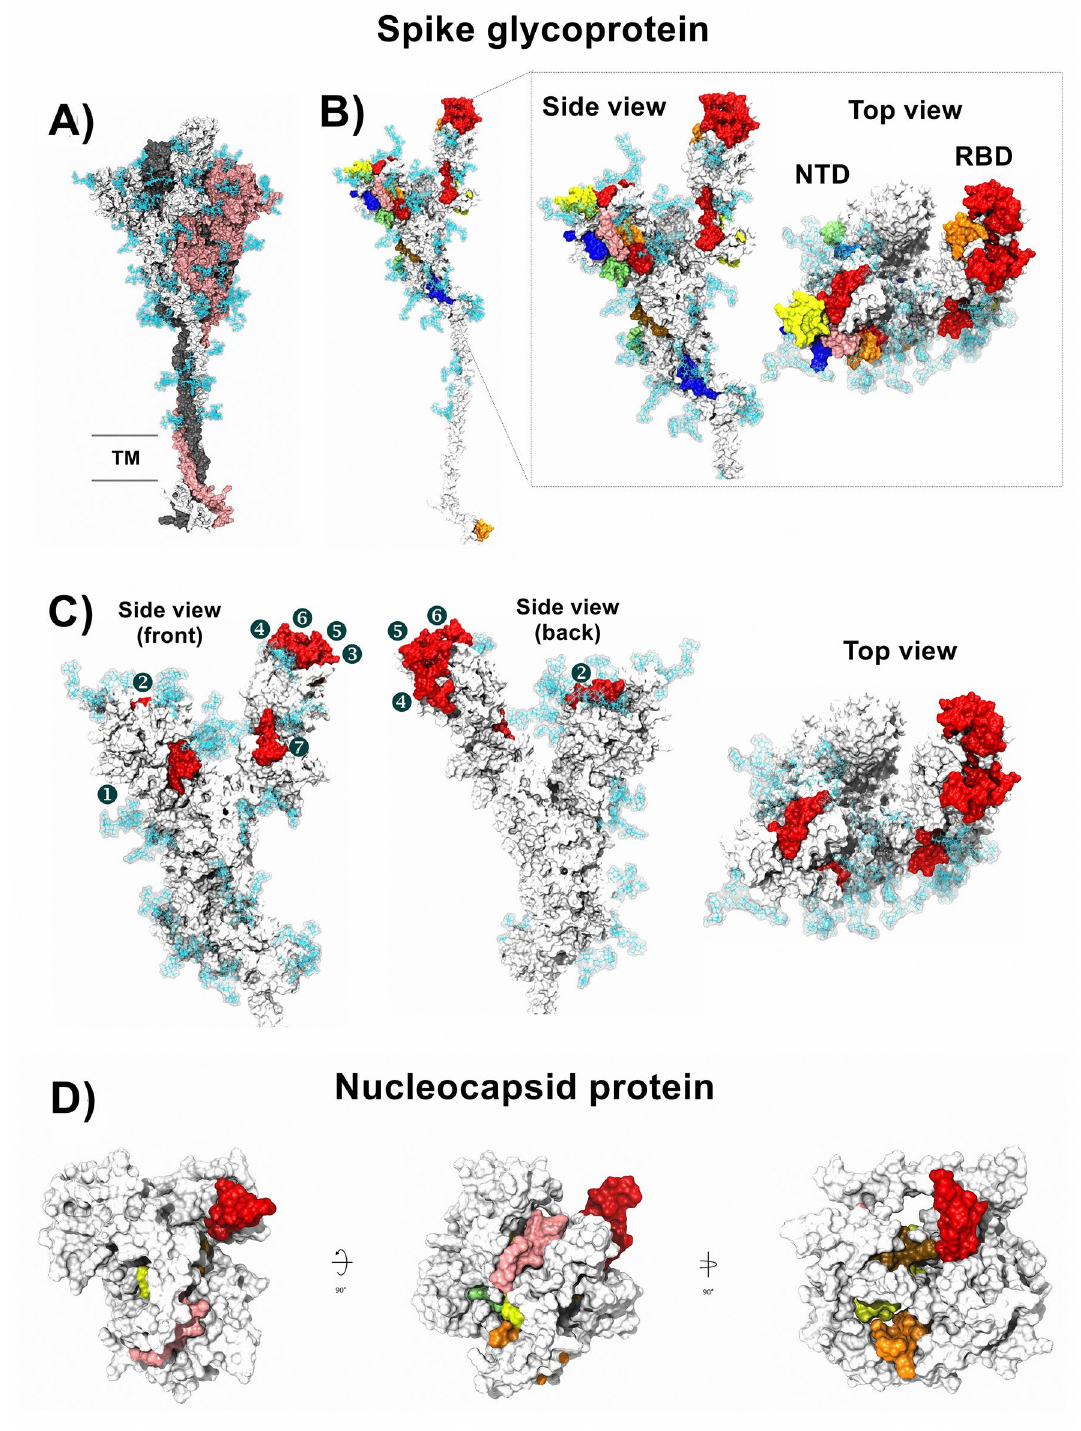
Figure 1. Localization of immunogenic and antigenic peptides in the 3D structures of SARS-CoV-2 S and N proteins. ( A ) The structure of the glycosylated trimeric S protein is shown in a side view. ( B ) Localization of all selected peptides in the monomeric glycosylated form of S protein. In the frame, the zoom of the side and top views of the S1 domain in the monomeric form of S protein shows the localization of each selected peptide in color patterns (see Supplementary Material S2). ( C ) Localization of the seven selected peptides (red) for the synthesis of MAP8 format is shown with numbers in side view (front and back) and top view. Glycans are represented as cyan lines of surf structures, and the transmembrane viral region is represented with two lines in gray (TM). ( D ) General view of a model structure of nucleocapsid protein. The color pattern used for each immunogenic and antigenic peptide located in the N protein is shown in Supplementary Material S2. Selected peptide is show in